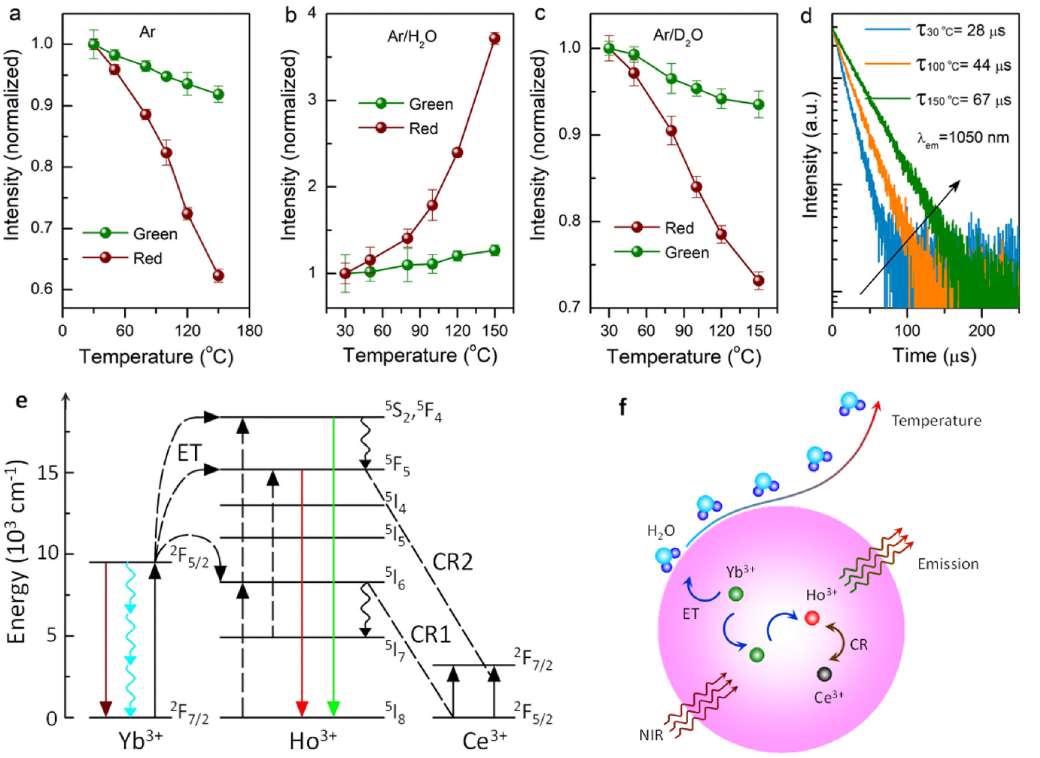
Figure 3: The UCL intensity of β -NaGdF 4 :Yb/Ce/Ho nanocrystals in (a) Ar, (b) Ar/H 2 O, and (c) Ar/D 2 O. Noting that the UCL intensity is normalized to that at 30 ° C (power density: 2.4 W/cm 2 ). (d) Time-dependent downshifting luminescence of Yb 3 + 2 F 5/2 energy level for the nanocrystals after 975 nm excitation at elevated temperature. Schematic representations of (e) upconversion process, and (f) energy transfer between active Ln 3 + ions as well as between Yb 3 + and H 2